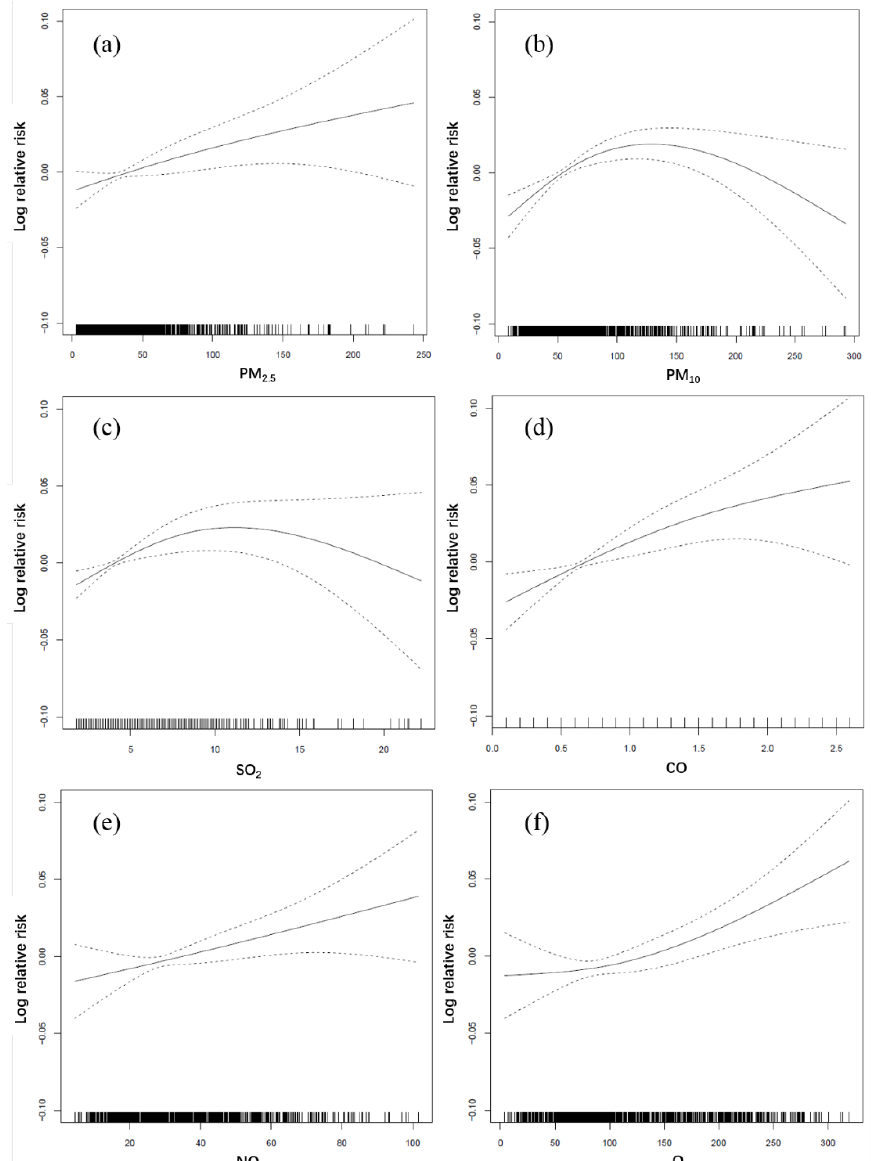
Figure 2. Exposure − response relationship of air pollutant concentrations with nonaccidental mor- tality in Beijing (2018−2020): ( a ) PM 2.5 ; ( b ) PM 10 ; ( c ) SO 2 ; ( d ) CO; ( e ) NO 2 ; ( f ) O 3 . The solid line represents the log relative risk of mortality, and the dashed lines represent the 95% confidence interval of the log relative risk.